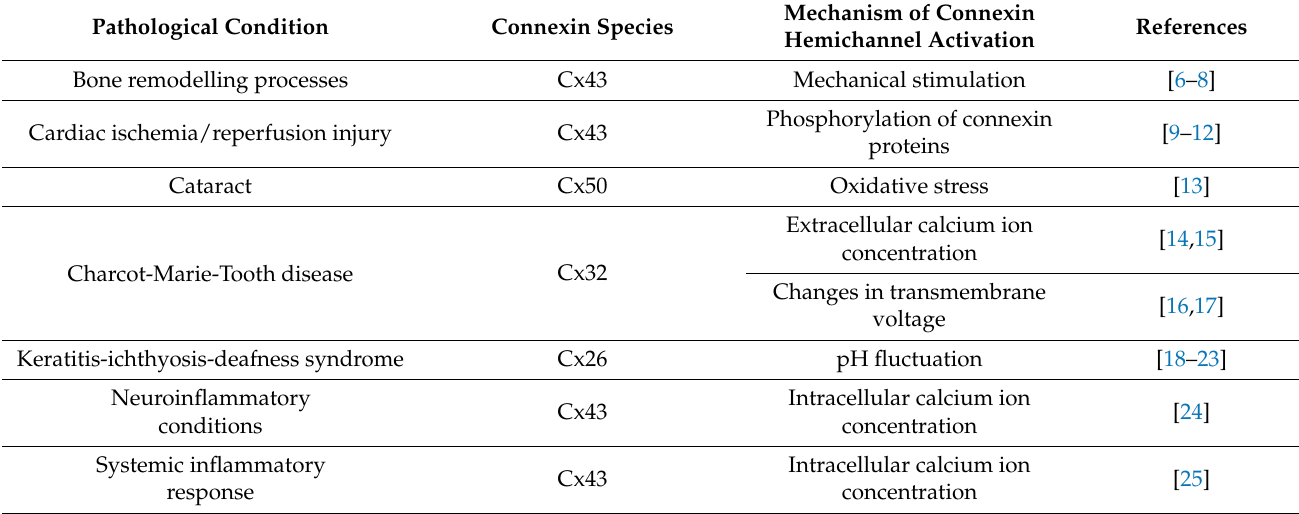
Table 1. Mechanisms underlying connexin hemichannel activation in disease.